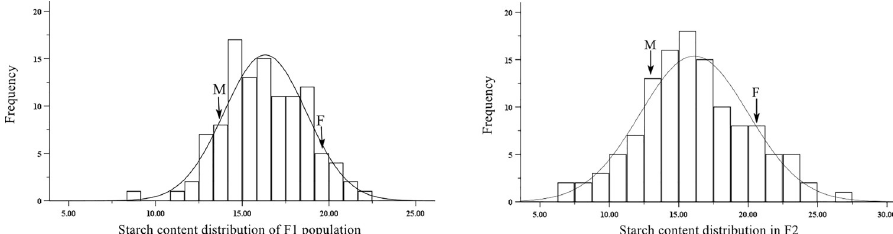
Fig 1. Phenotypic distributions of starch content traits in F 1 and F 2 potato